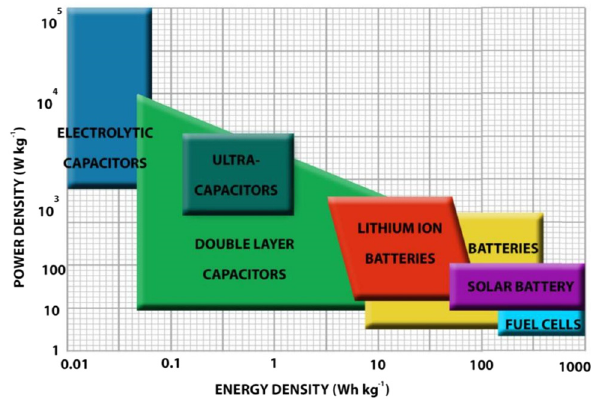
Figure 2: Ragone diagram for di ff erent energy storage devices [ 8 ]